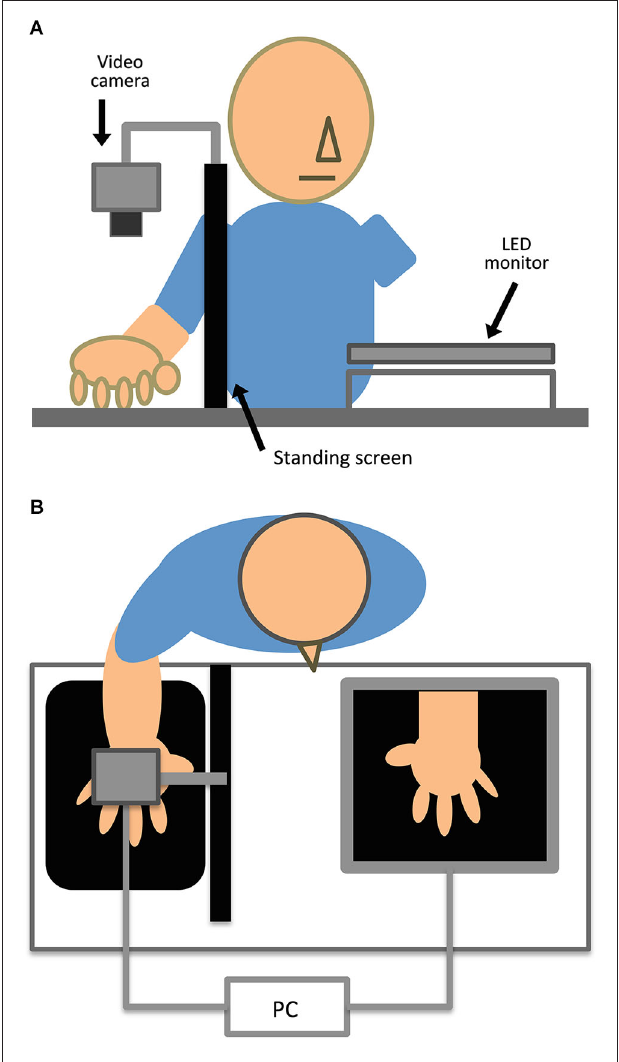
FIGURE 1 | Experimental setup depicted in (A) elevated and (B) horizontal views. Participants sat at the table and placed their right hand on the tabletop. Control participants placed their left hand in the gap between the LED monitor and table. A steel framework fixed the video camera and black standing screen. LED lighting lit the space near the right